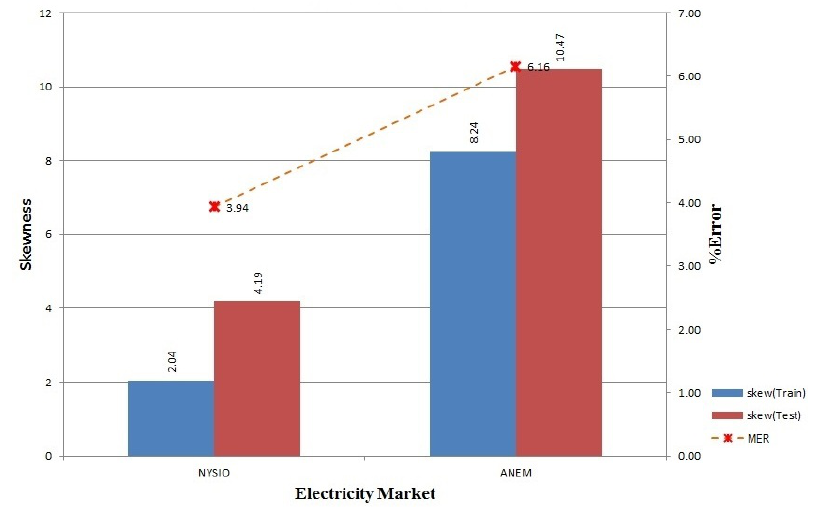
Figure 10. Skewness in training and testing data for NYISO and ANEM